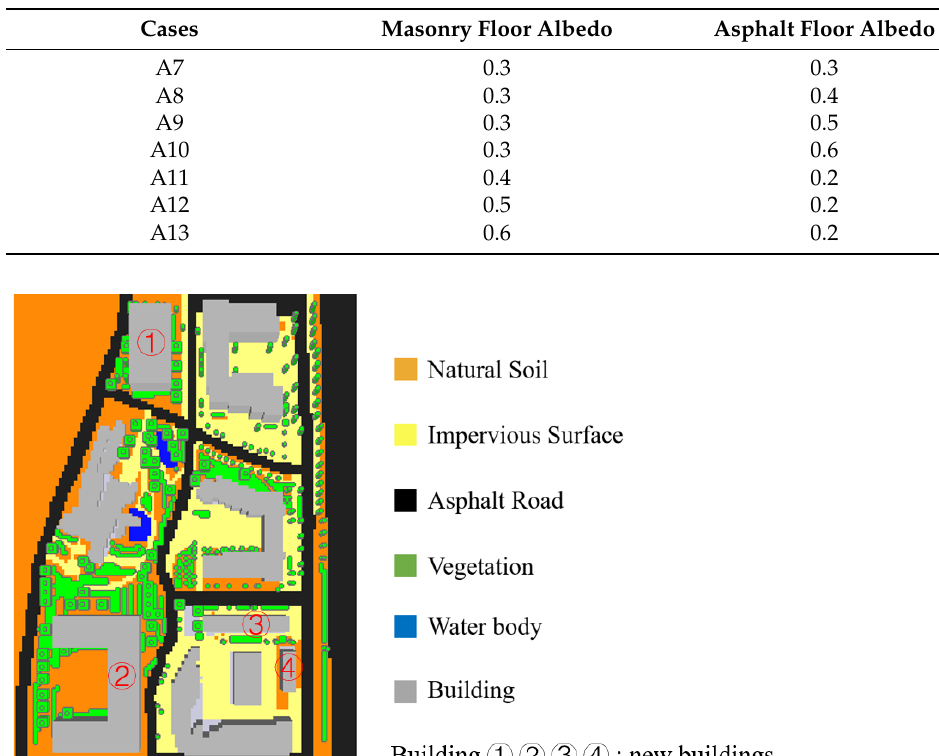
Table 5. Cases for building layout.